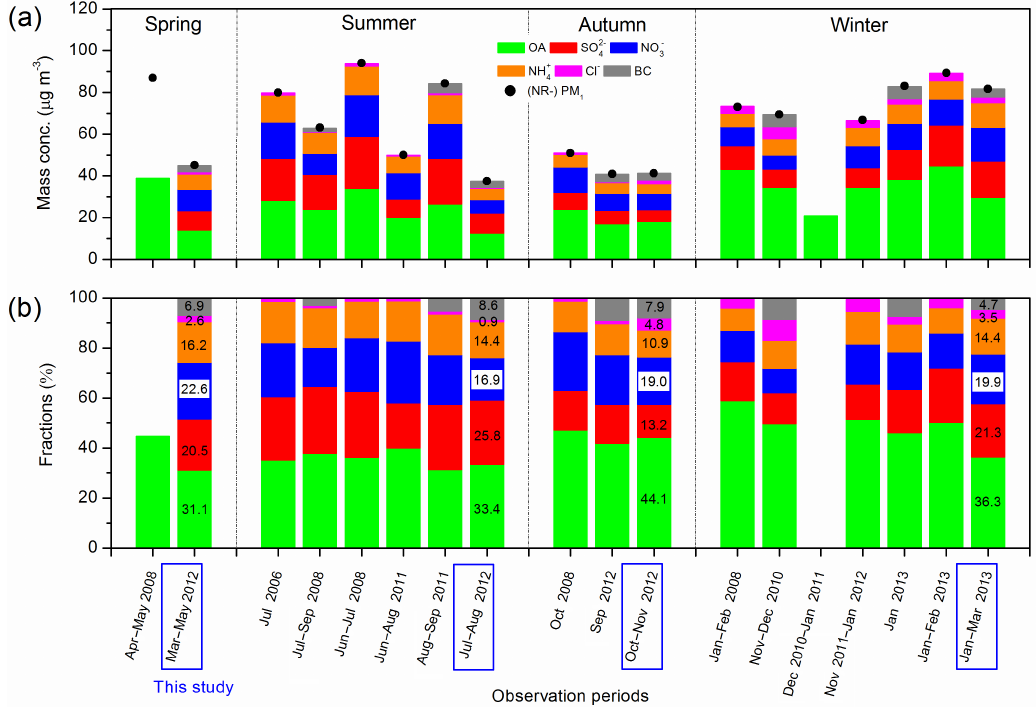
Figure 1. Concentrations (a) and fractions (b) of main chemical components in PM 1 during seasonal observations in Beijing in recent years. The data and references are available in Table S3 in the